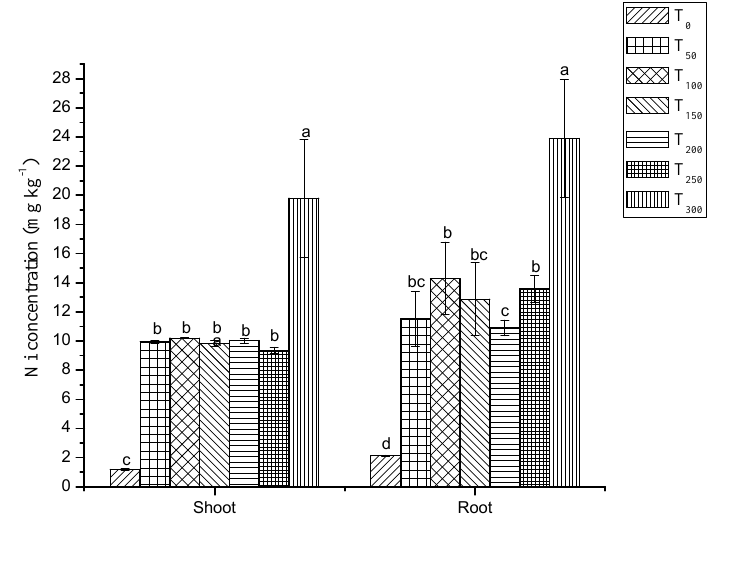
Figure 3: Ni concentrations in shoot and root of C. aciculatus grown in soils contaminated with different concentrations of Ni.